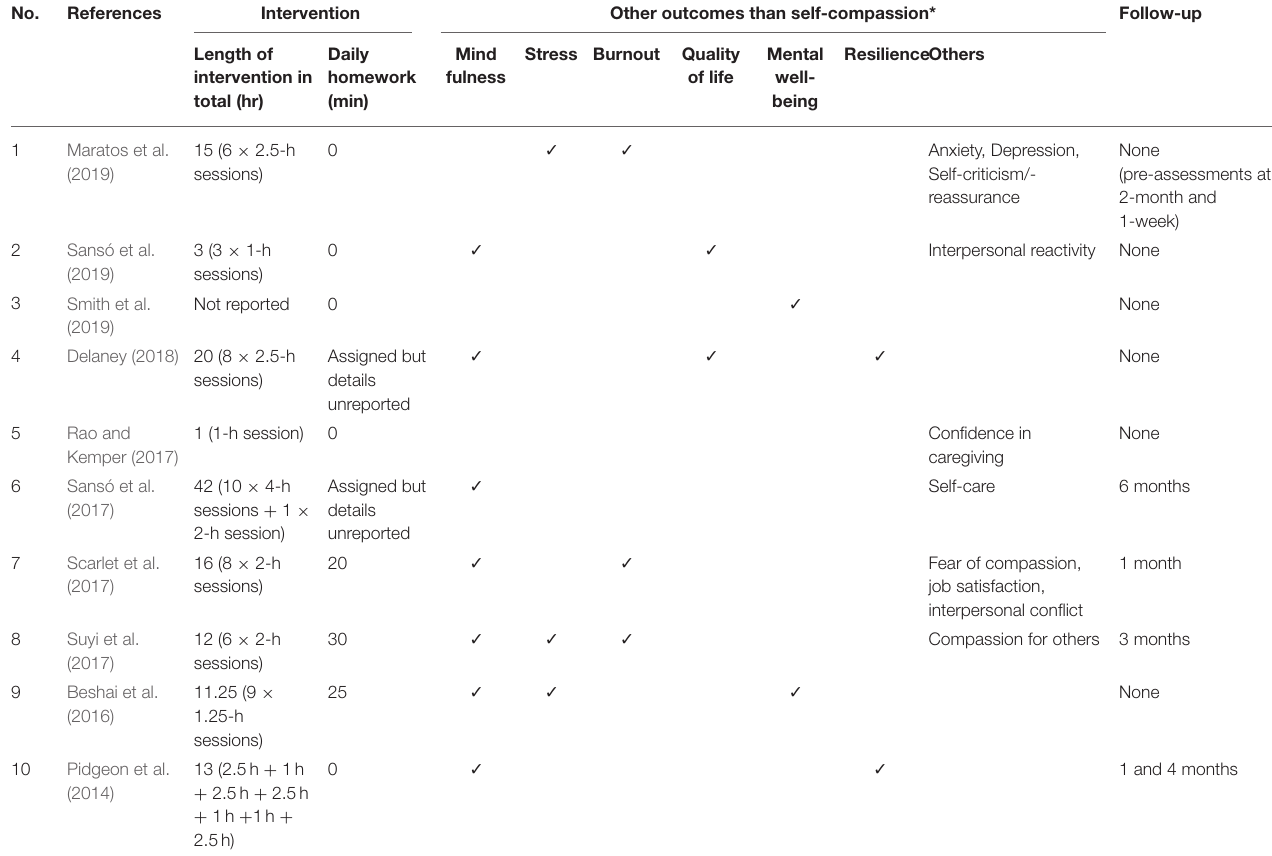
TABLE 3 | Intervention, psychological outcomes, and follow-up in the 10 included studies.